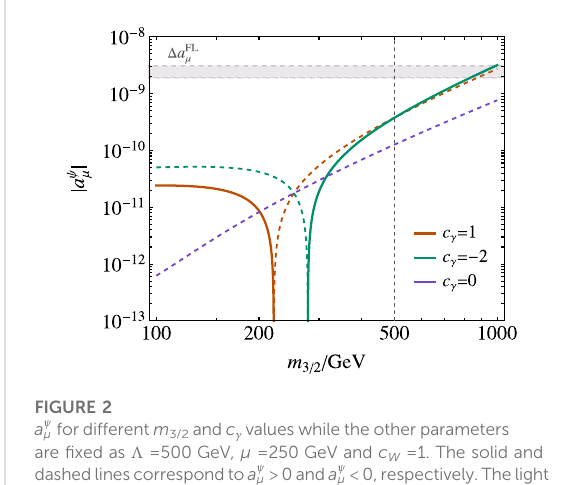
FIGURE 2 a ψ μ for different m 3/2 and c γ values while the other parameters are fi xed as Λ =500 GeV, μ =250 GeV and c W =1. The solid and dashedlinescorrespondto a ψ μ > 0and a ψ μ < 0,respectively.Thelight grey region represents the 1 σ band of the Fermilab measurement. On the right of the vertical thin dashed line where m 3/2 > Λ , the EFT approach starts to be